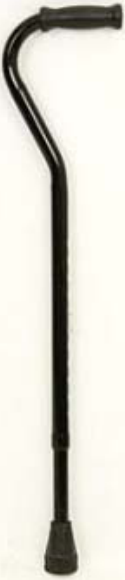
Figure 2. Invacare Bariatric